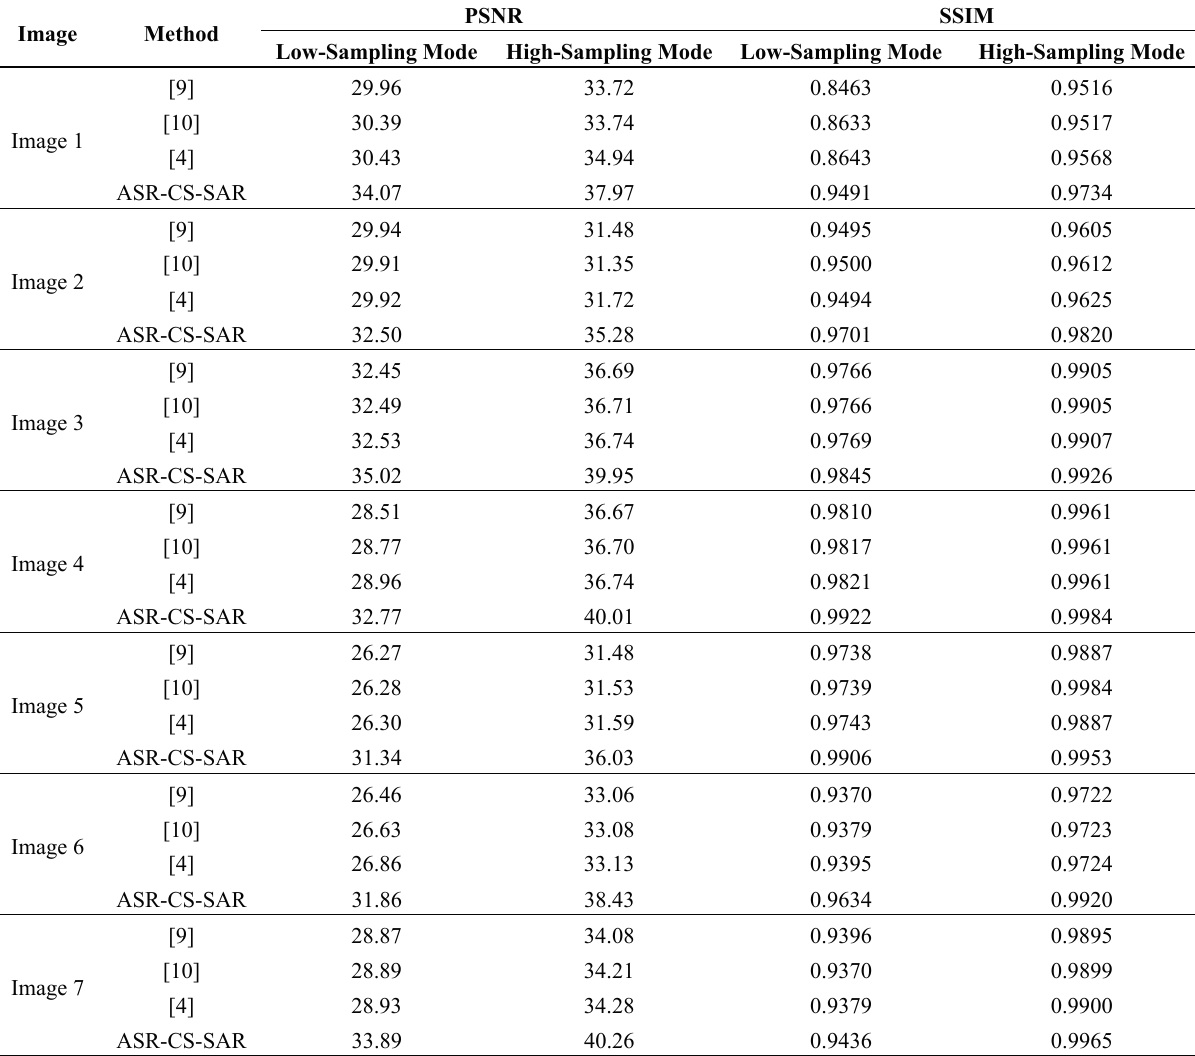
Table 3. Quality metrics for reconstructed